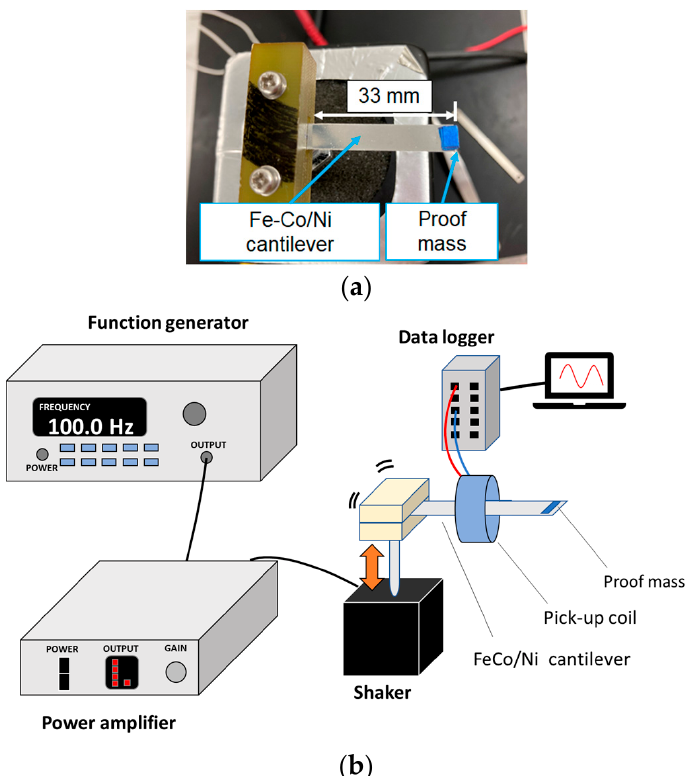
Figure 2. Schematic of ( a ) specimen and ( b ) experimental setup.